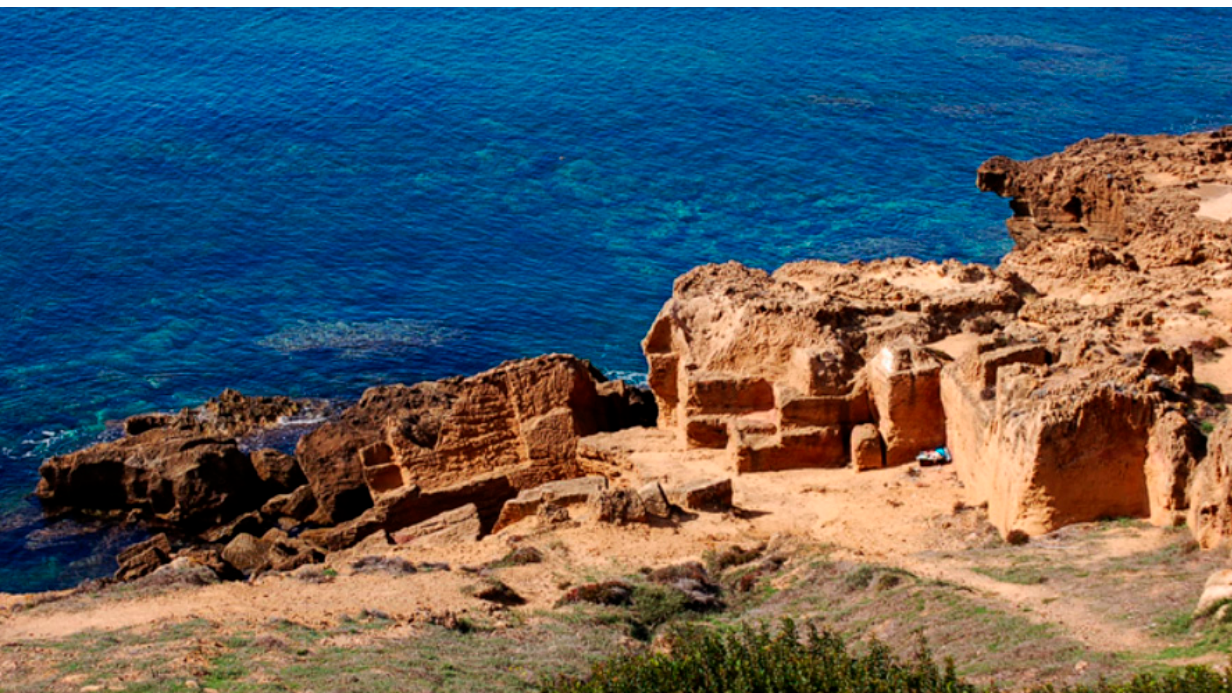
Figure 15. Ancient quarry of sandstone (called “s’Enna ‘e s’Arca”) used in Punic and Roman times located on the western coast of Sardinia (see Figure 4).